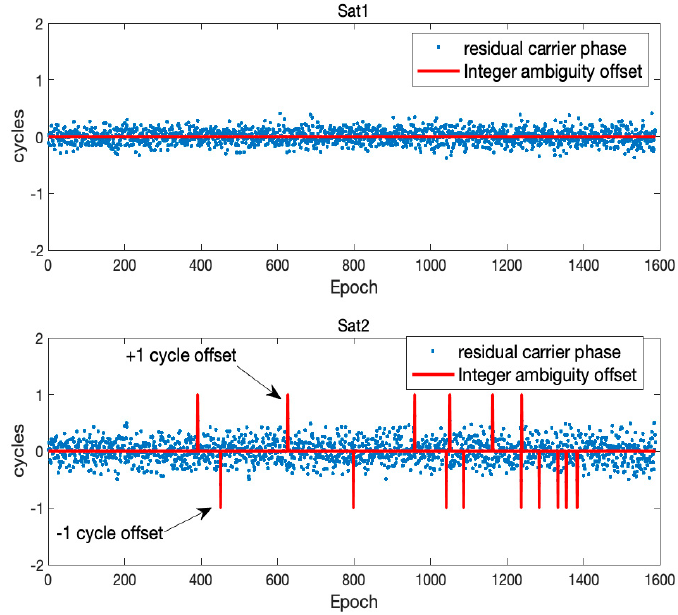
Figure 2. Two examples of residual double difference carrier phase measurements in cycles subtracted from the correct integer ambiguities. Satellite 1 (Sat1) has no wrong integer ambiguity offsets, but satellite 2 (Sat2) suffers from many wrong ones.